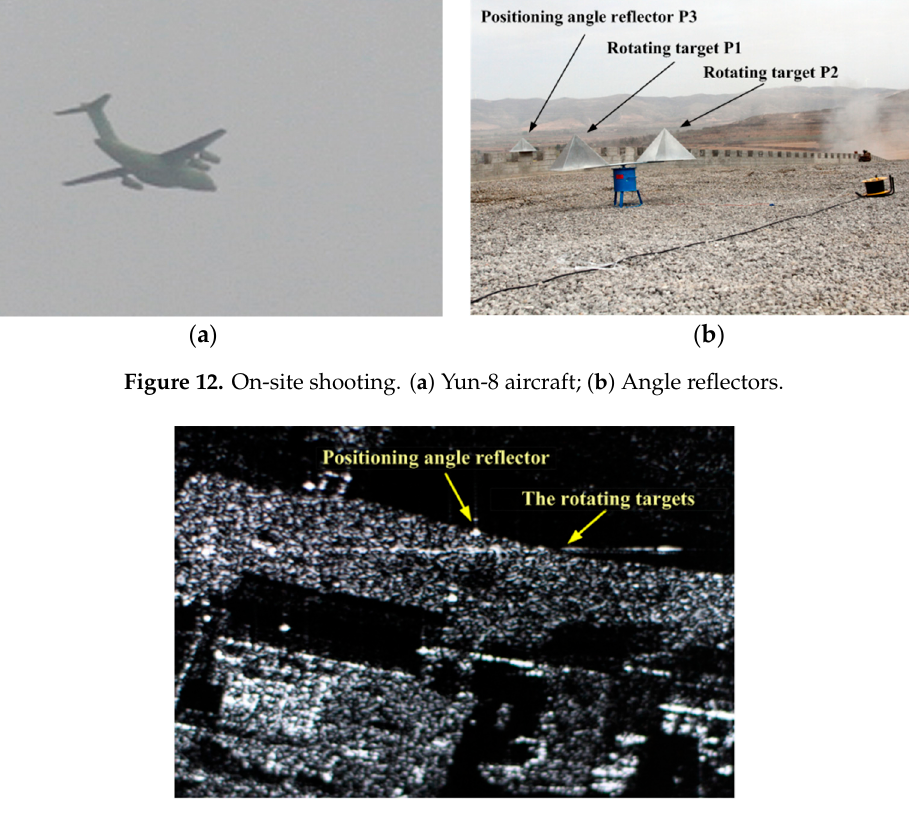
( f ) Figure 14. Simulation detection result of rotating angle reflectors. ( a ) TF distribution result of the azimuth echo; ( b )